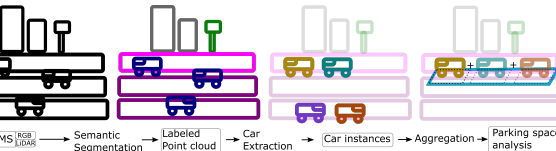
Figure 1. Overview of the processing pipeline.